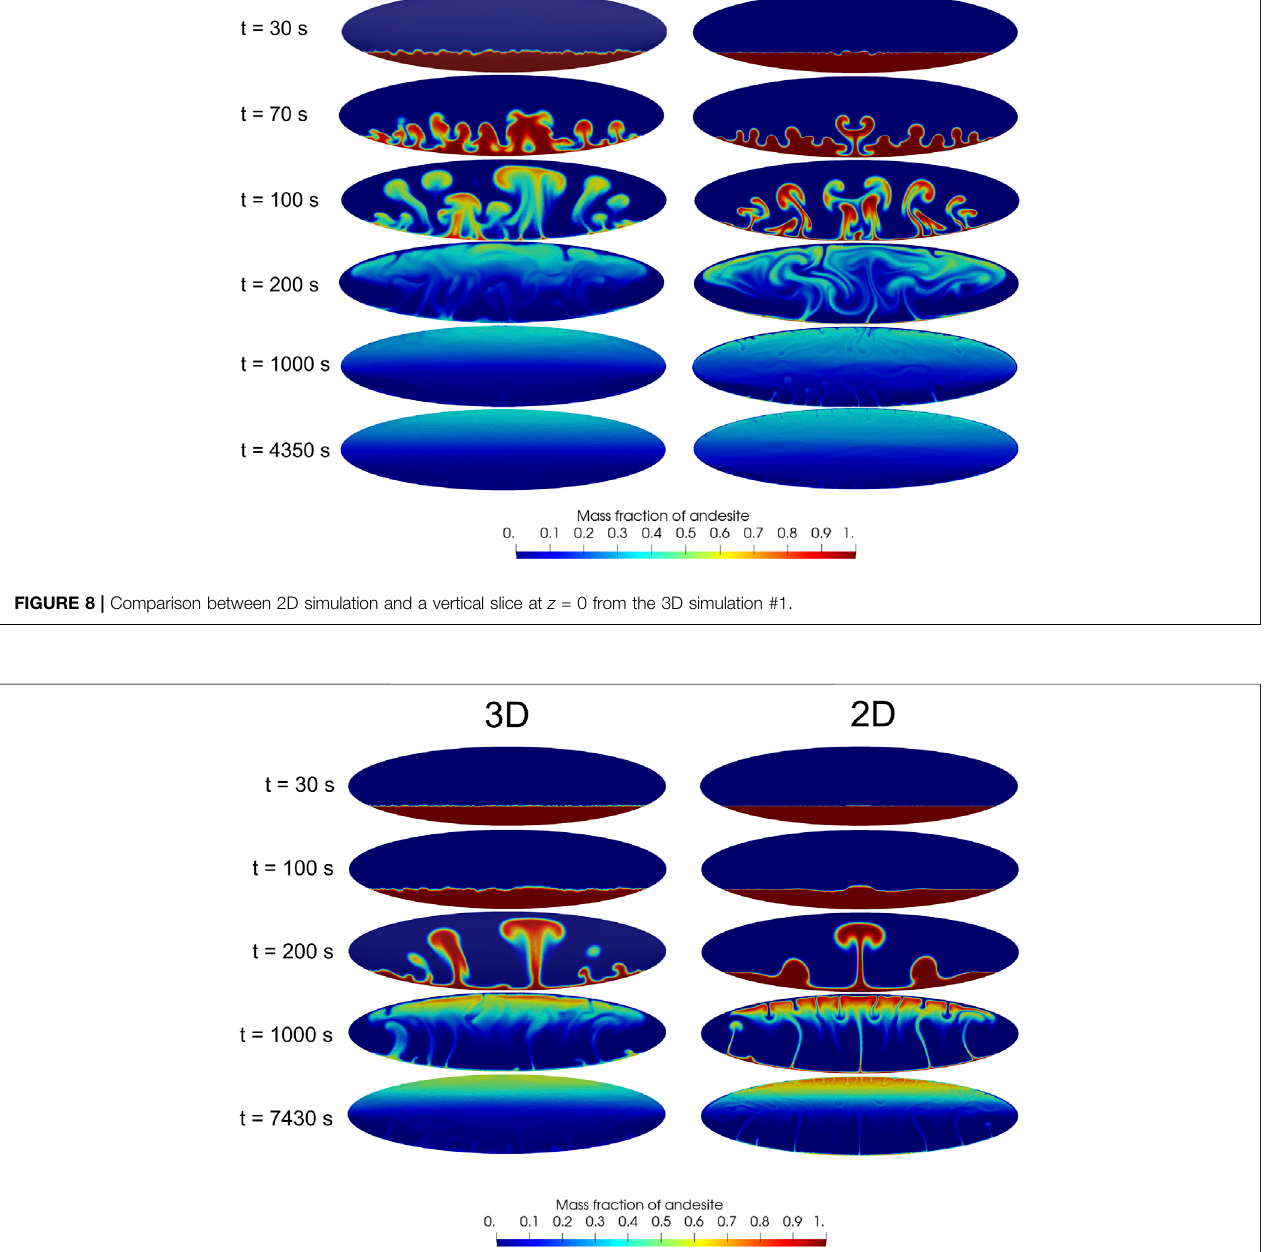
Frontiers in Earth Science |